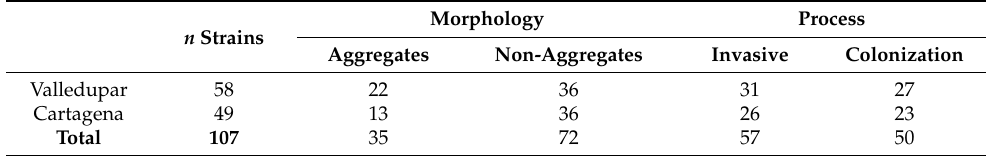
Table 1. Strains used in this study are shown. Number of isolates and type of morphology of C. auris recovered from invasive and colonization processes in Colombian patients ( p = 0.814). Morphology Process n Strains Aggregates Non-Aggregates Invasive Colonization Valledupar 58 22 36 31 27 Cartagena 49 13 36 26 23 Total 107 35 72 57